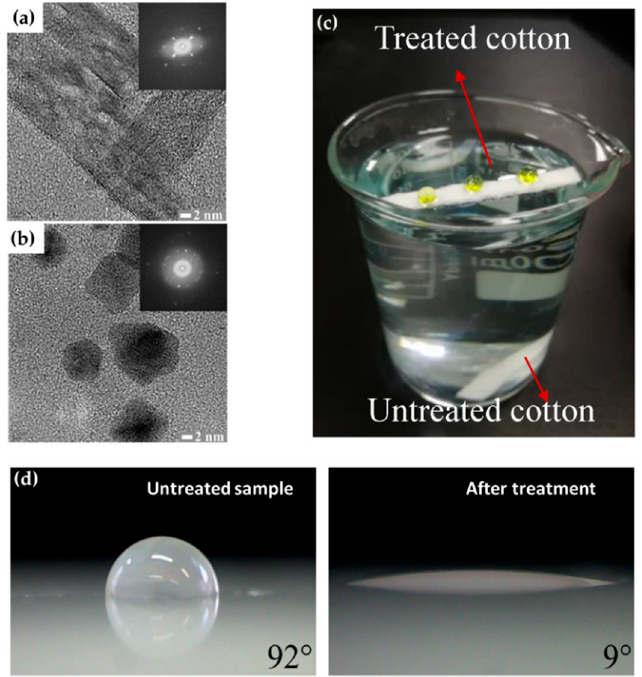
Figure 17. Transmission electron microscopy (TEM) images of polypyrrole NPs with ( a ) single- crystalline and ( b ) polycrystalline properties [62]. ( c ) Superhydrophobicity of the coated films on the cotton fabrics [67]. ( d ) Hydrophilization of the surface of polypropylene [73].